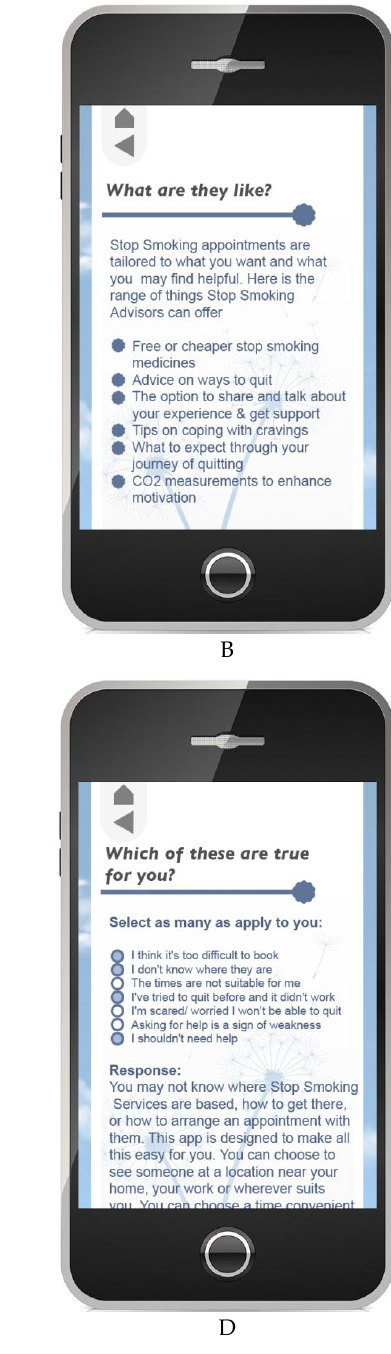
Figure 3. Screenshots from prototype app: ( A ) part of the introduction to the app; ( B ) information